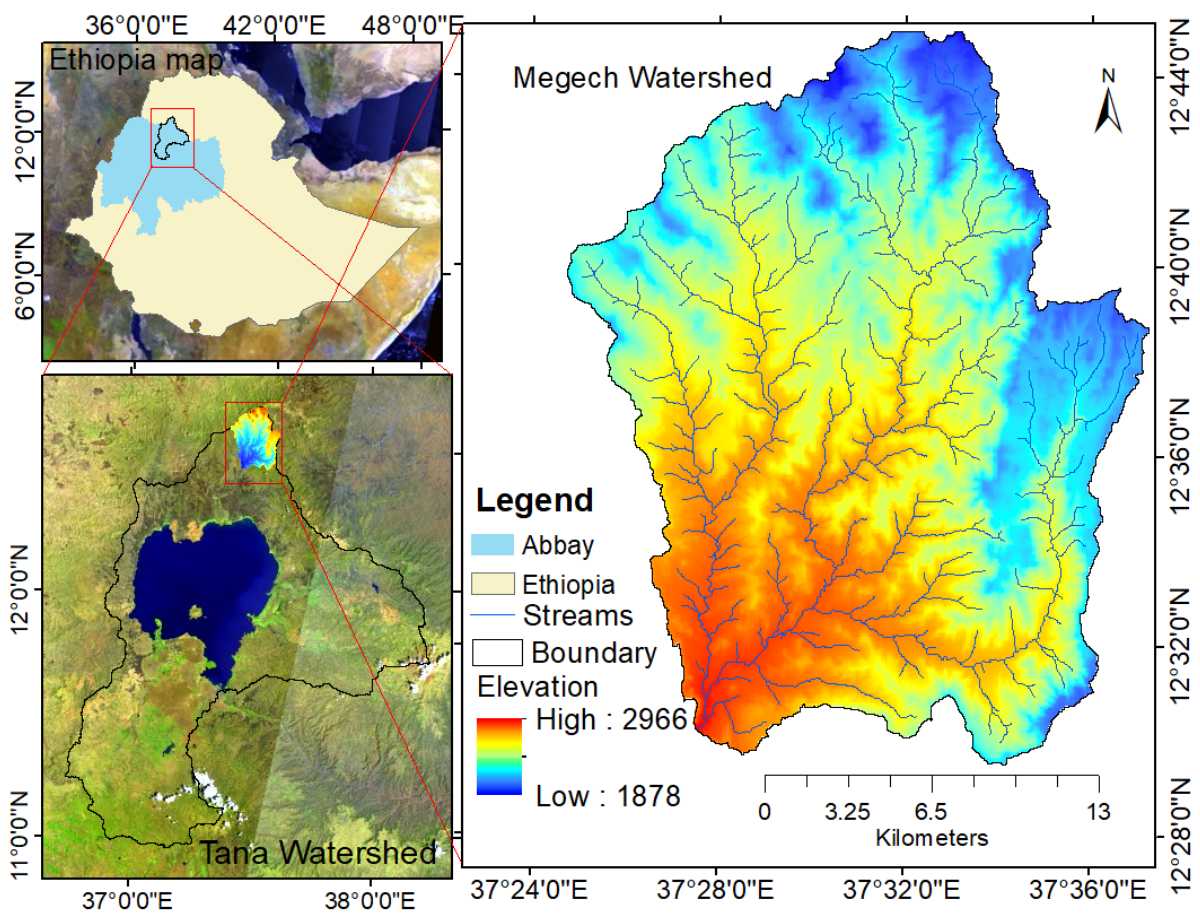
Figure 1. Study area map.